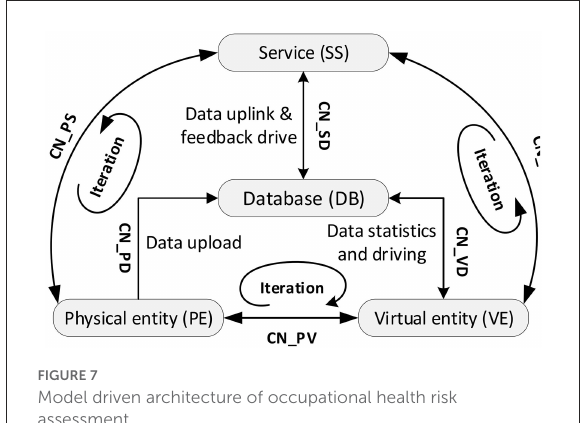
FIGURE7 Model driven architecture of occupational health risk